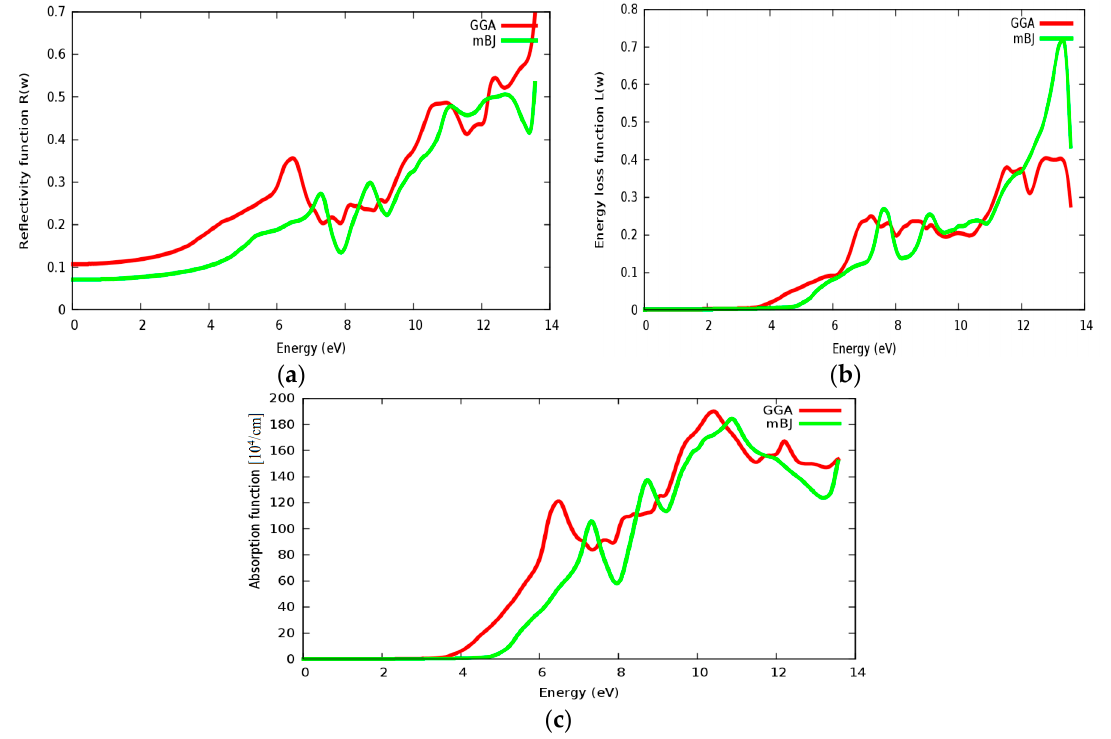
Figure 17. ( a ) Reflectivity function R ( ω ); ( b ) Energy loss function L ( ω ) and ( c ) absorption function for SrZrO 3 compound using both PBE-GGA and mBJ-GGA methods.